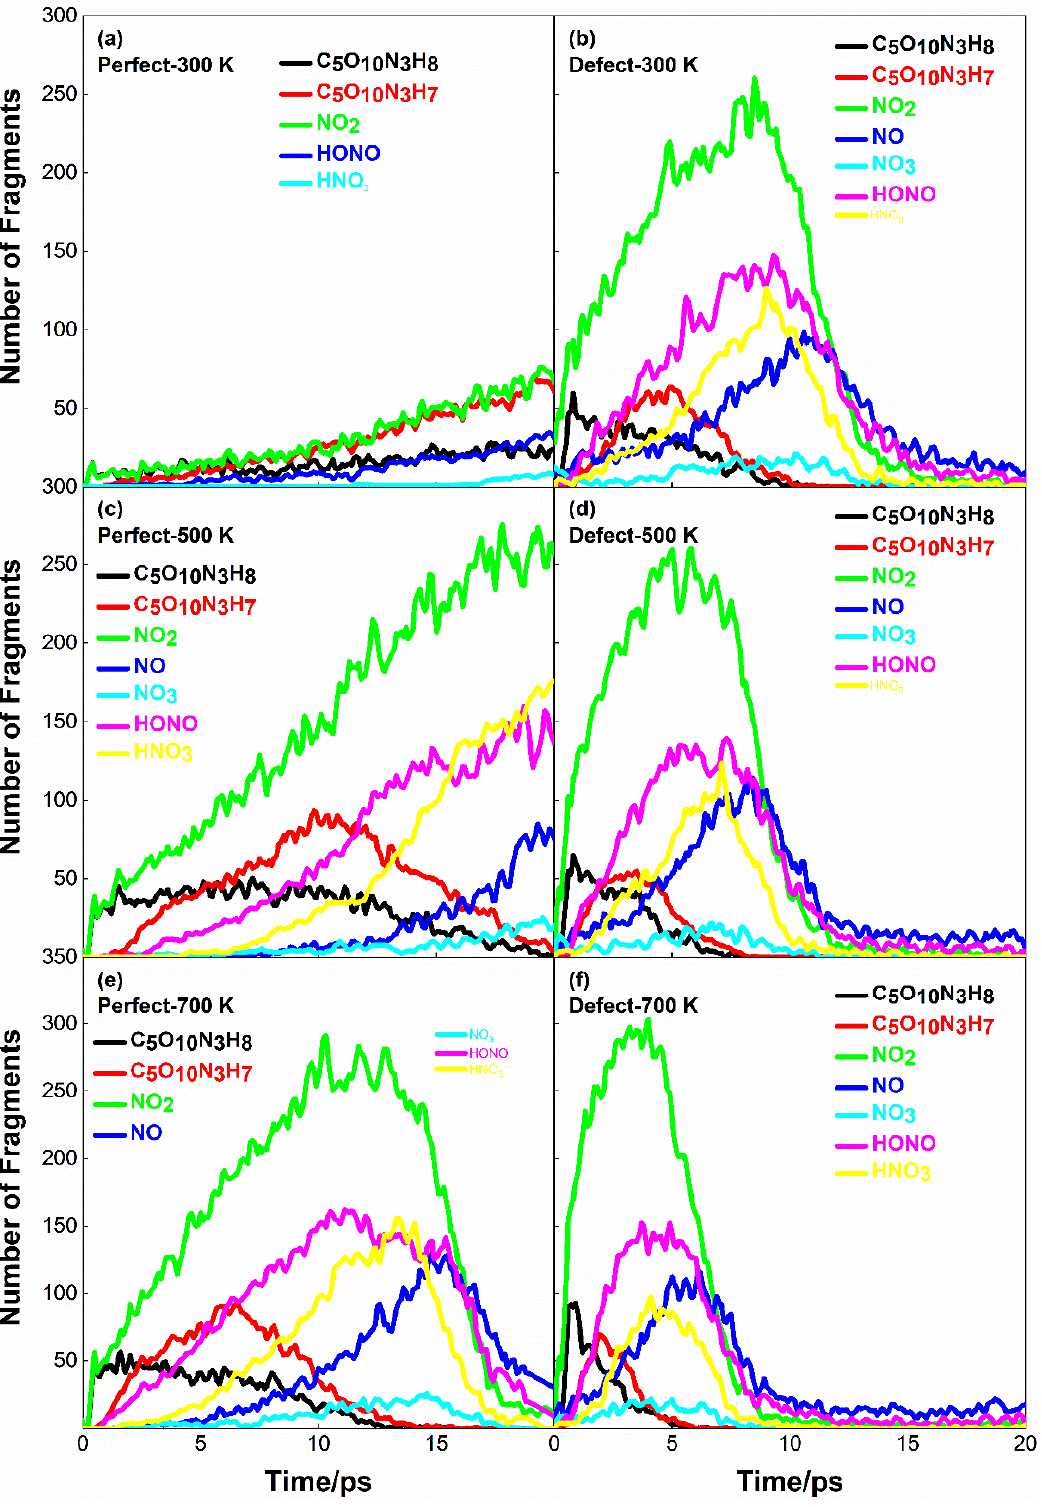
Figure 5. Evolution curves of initial decomposition products for the case of U s = 8 km·s − 1 . ( a , c , e ) correspond to perfect PETN crystal with preheating temperatures 300 K, 500 K, and 700 K; ( b , d , f ) correspond to defective PETN crystal with preheating temperatures 300 K, 500 K, and 700 K.